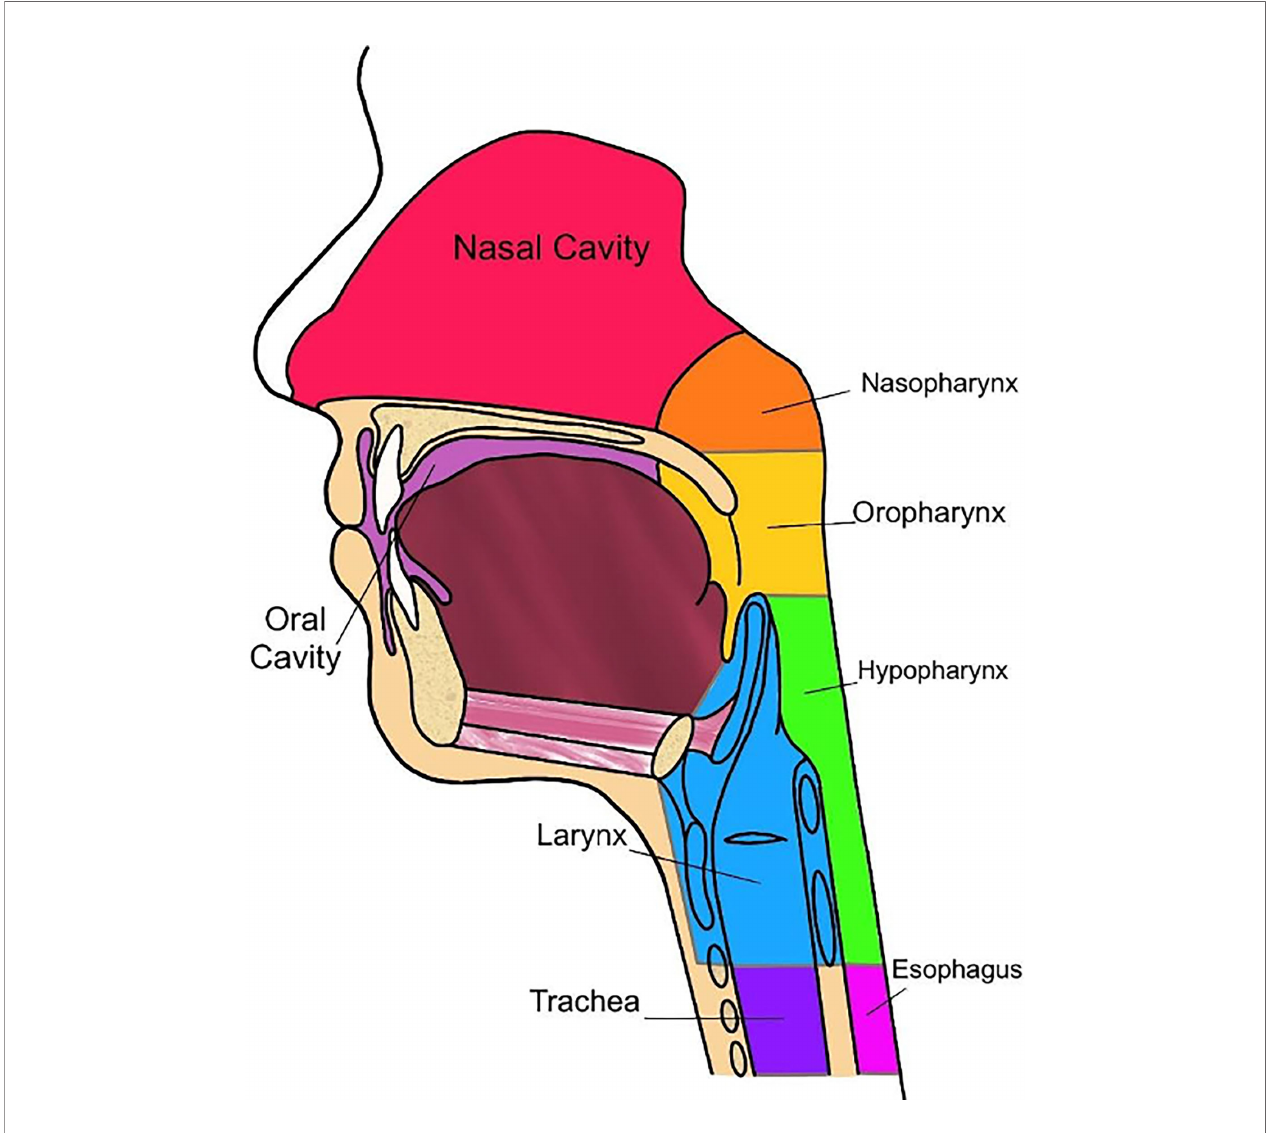
FIGURE 2 | Anatomy of ear, nose, and throat, sagittal